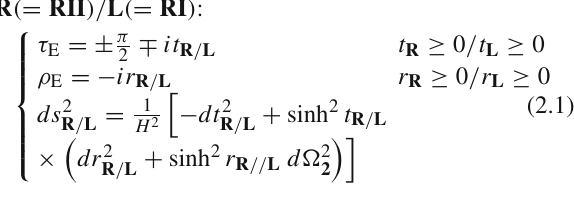
most effective approach and the nature of quantum